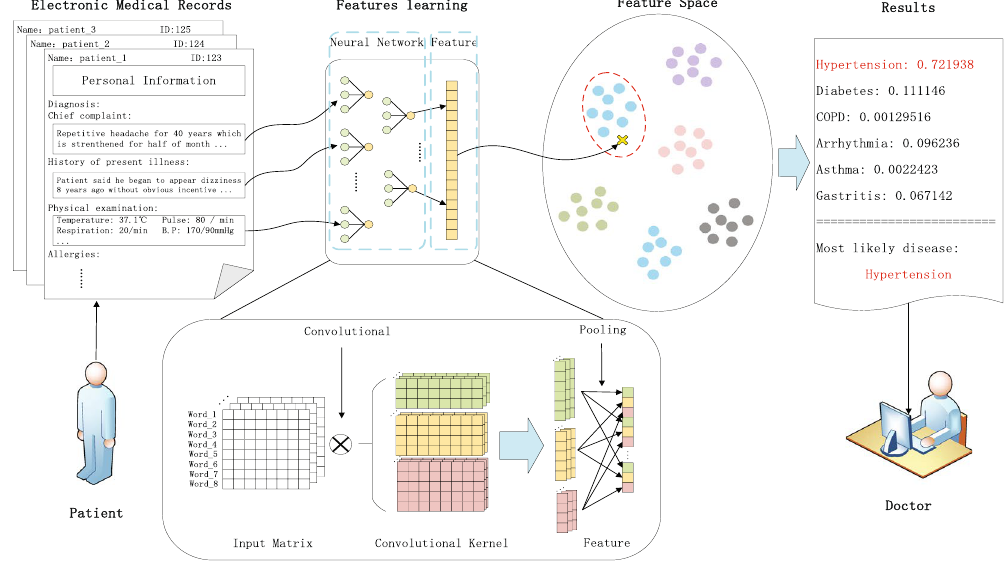
Figure 1. The overall framework of the proposed model. We use the convolutional neural network to extract the semantic feature vectors of unstructured electronic medical records and map them to the feature space, finally we use the classifier to calculate the probable probability of each disease and select the highest probability of the disease as the auxiliary diagnosis of our